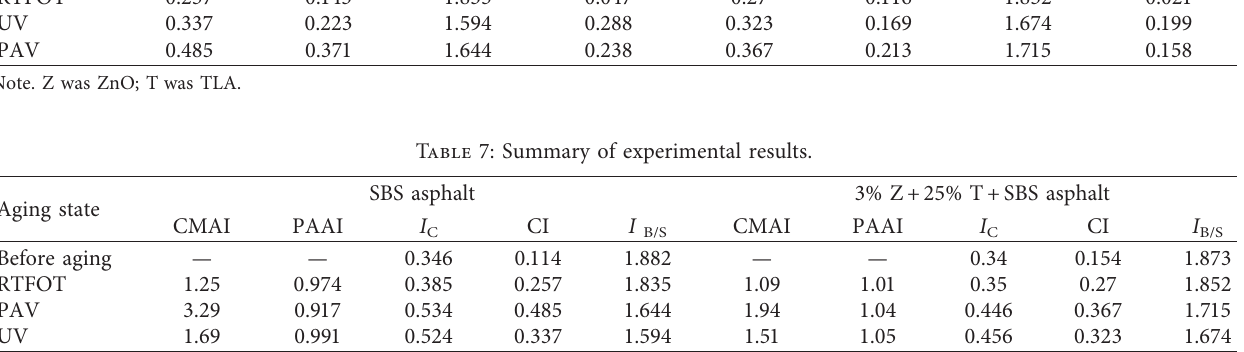
Table 6: Table of changes in asphalt carbonyl index (CI) and styrene index ( I Aging state